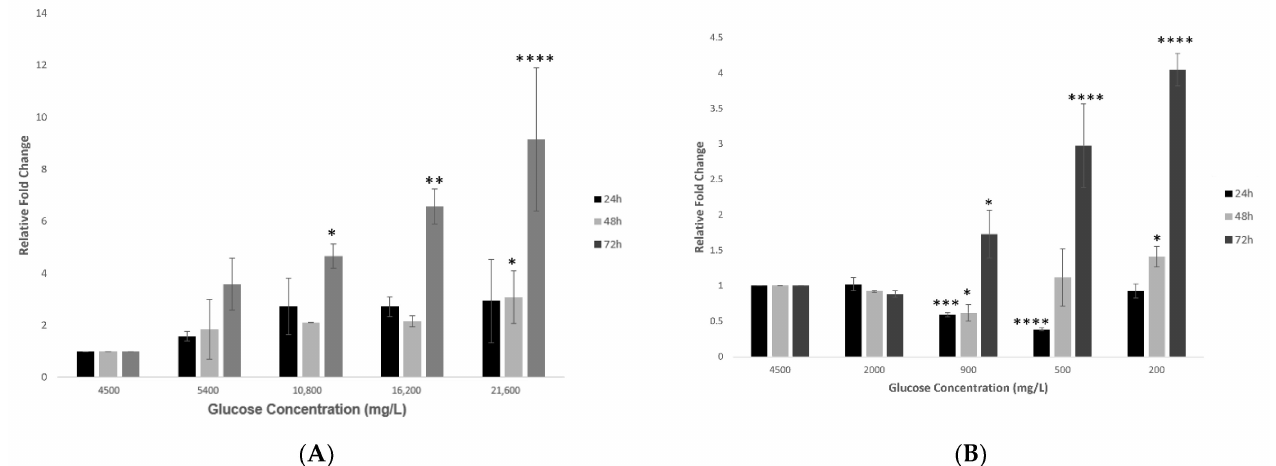
Figure 2. Gene expression of ACE2 in hypothalamic neurons under various glucose concentrations at different time points. ( A ) Increase in glucose concentrations (mg/L) of 5400, 10,800, 16,200, and 21600 at 24, 48 and 72 h time points showed an increase in ACE2 (cid:48) s gene expression, with significant fold changes observed at the higher concentrations of 10,800, 16,200, and 21,600 mg/L after longest exposure of 72 h as compared to the control condition (4500 mg/L). ( B ) Decreasing glucose concentrations (mg/L) of 2000, 900, 500, and 200 at 24, 48 and 72 h time points also showed an increase in gene expression of ACE2 , with significant fold changes observed at the lower concentrations of 500 and 200 mg/L at 72 h time point, as compared to the control condition (4500 mg/L). Data is represented as mean ± SEM ( n = 4, * p < 0.05, ** p < 0.01, *** p < 0.001, **** p <